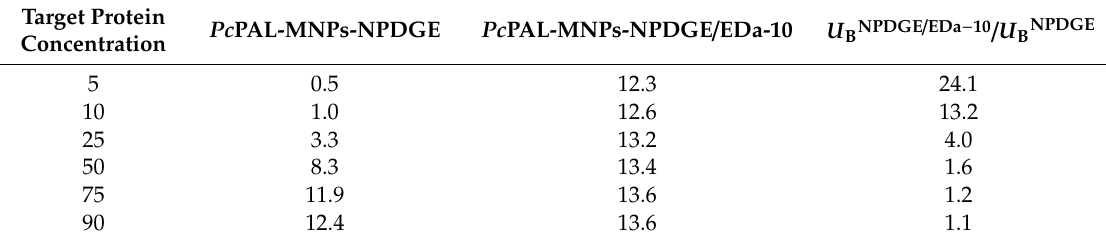
Table 3. Comparison of the e ffi ciency of Pc PAL immobilization [ U B ( µ mol × min − 1 × g − 1 )] with